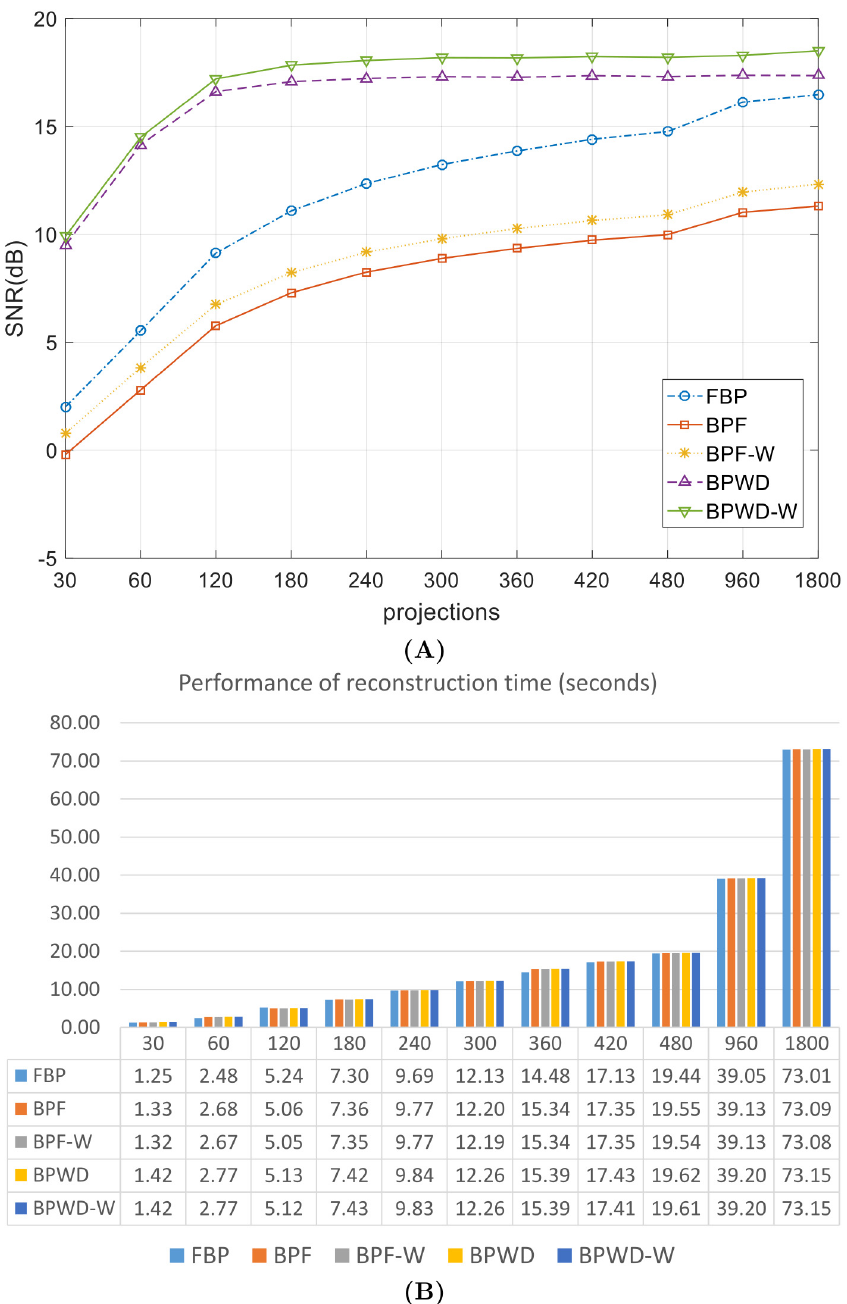
Fig 7. Performance comparison of different methods based on simulations. (A) SNR performance; (B) reconstruction